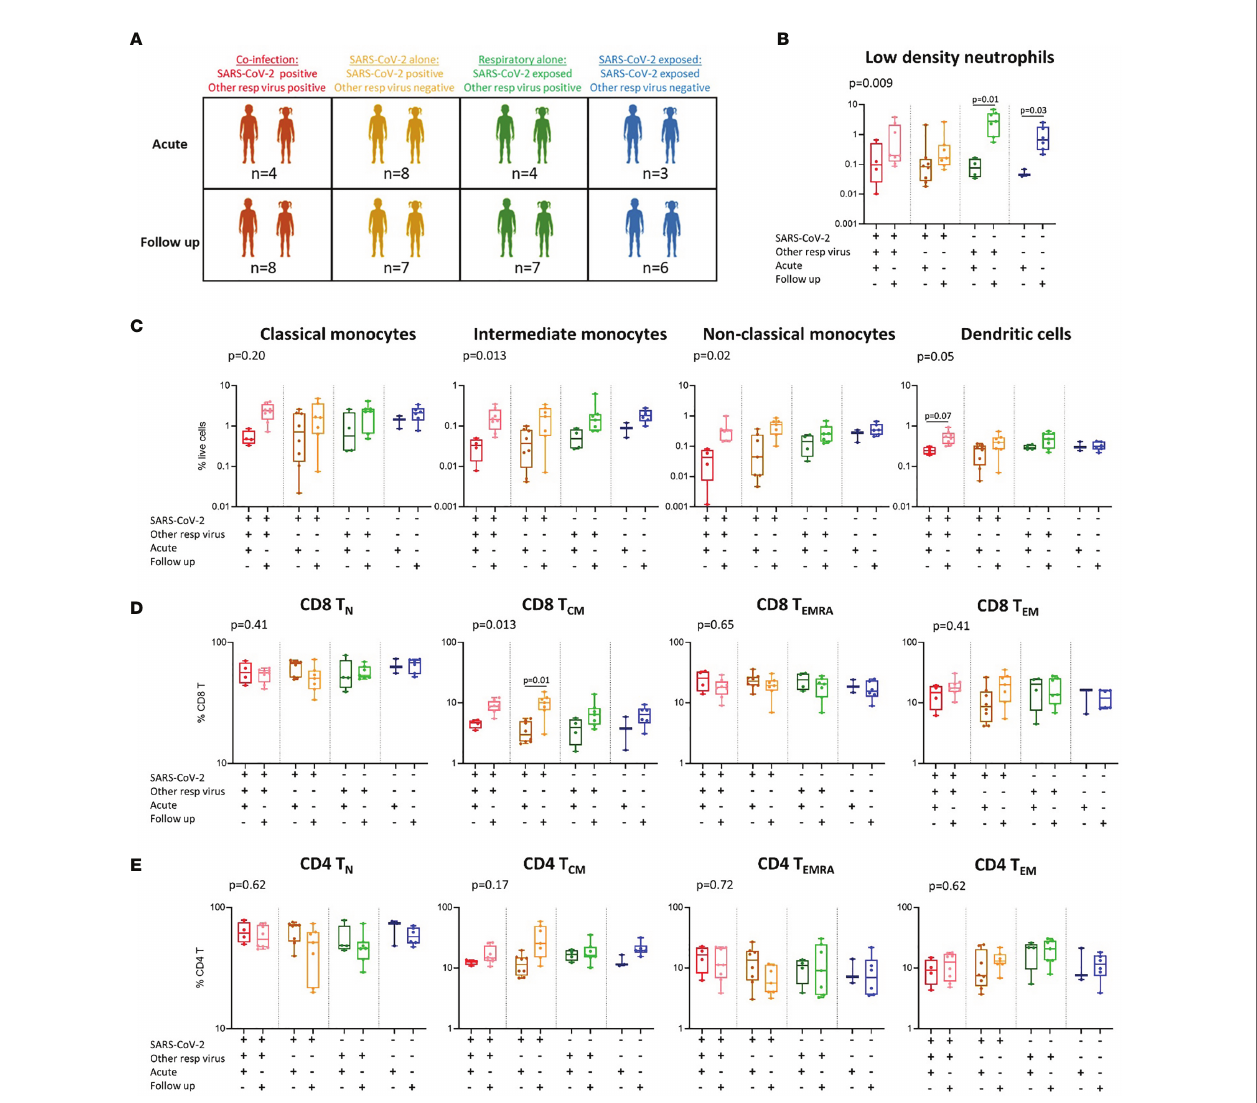
FIGURE 4 | Immune pro fi les in children with SARS-CoV-2 single infection, SARS-CoV-2 co-infection, and non-SARS-CoV-2 respiratory infection. (A) A strati fi ed analysis of samples collected from children with SARS-CoV-2 co-infection [SARS-CoV-2 positive, other respiratory virus positive (n=4 acute, n=8 follow up)], SARS- CoV-2 infection alone [SARS-CoV-2 positive, other respiratory virus negative (n=8 acute, n=7 follow up)], respiratory virus alone (SARS-CoV-2 negative (exposed), other respiratory virus positive (n=4 acute, n=7 follow up)], and SARS-CoV-2 exposed alone (SARS-CoV-2 negative, other respiratory virus negative (n=3 acute, n=6 follow up)]. (B) Proportions of low-density neutrophils. (C) Proportions of monocyte subsets and dendritic cells. (D) CD8 T cell naïve (T N ), central memory (T CM ), effector (T EMRA ) and effector memory (T EM ) populations in each group. (E) CD4 T cell naïve (T N ), central memory (T CM ), effector (T EMRA ) and effector memory (T EM ) populations in each group. P values by Kruskal-Wallis rank sum test and Dunn ’ s multiple comparison testing. FDR-adjusted P-values are reported. Boxplots show the medians, the 1 st and 3 rd quartile as well as the smallest and largest values as